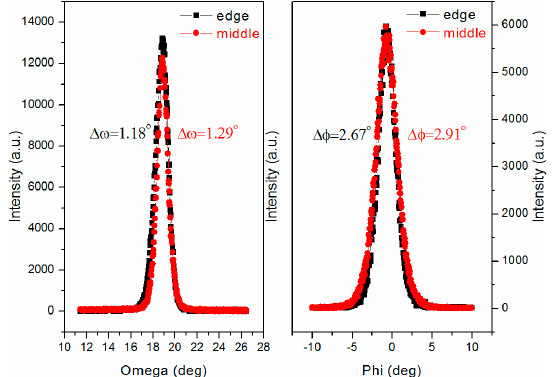
Figure 9. The XRD ω -scan of GdYBCO (005) and the XRD φ -scan of GdYBCO (103) based on the multi-aperture shower.